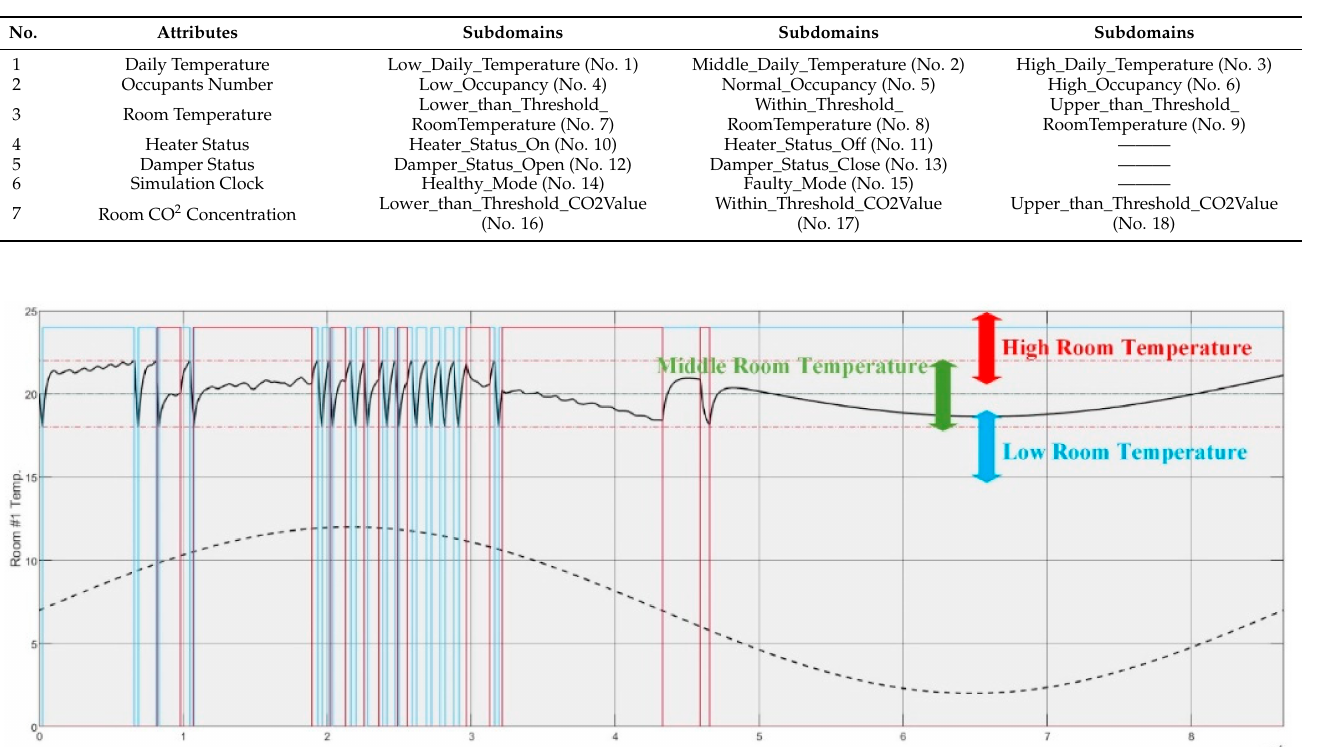
Table 14. Use-case SLT.